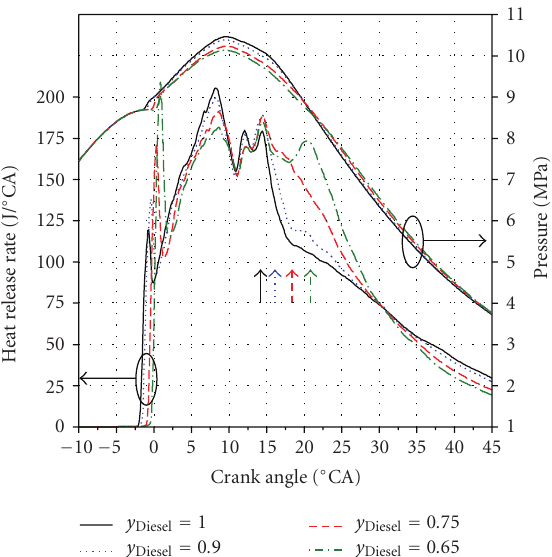
Figure 16: Heat release rate and pressure history for fuels with di ff erent water